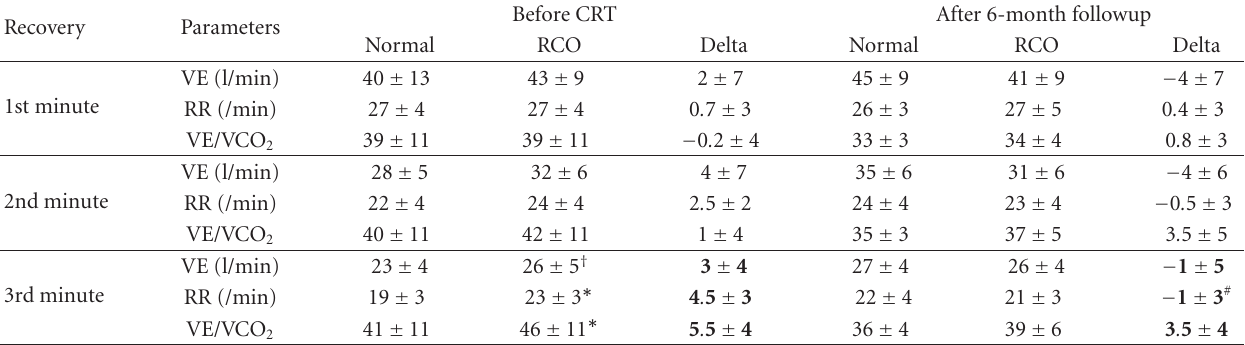
Table 4: Ventilatory variables during recovery with (RCO) and without (normal) regional circulatory occlusion. Values are given as means